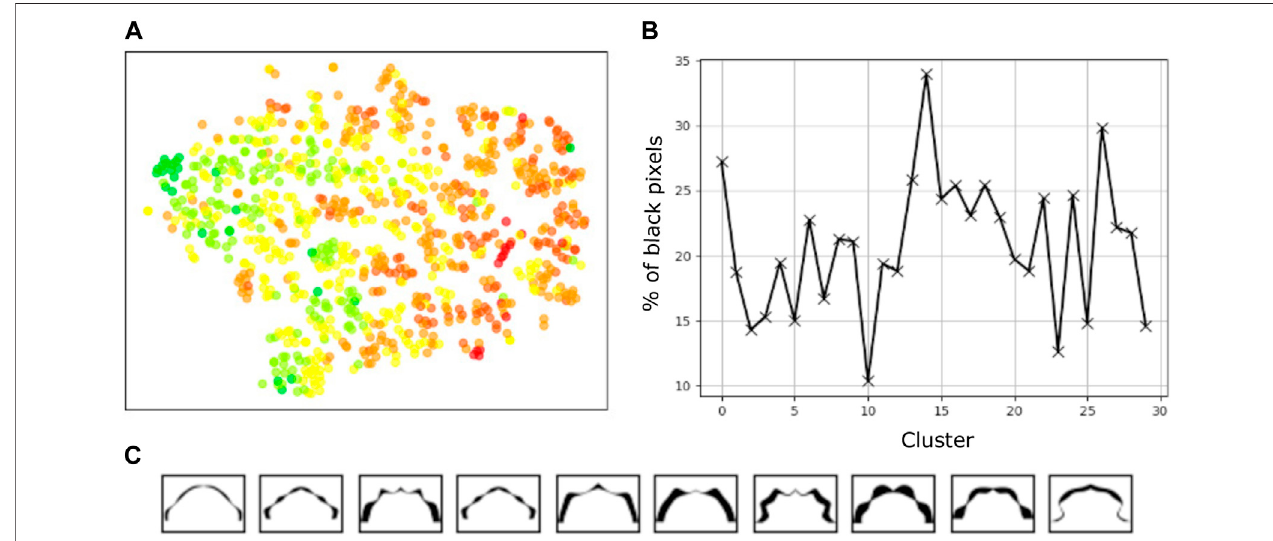
FIGURE 4 | Latent space representation of the data points coloured depending on the occupancy of the arches (a measure of the material usage) for the seismic design scenario. The latent space (A) is presented together with the plot of the mean occupancy of each cluster (B) and sample shapes from the best selected cluster (C) . Adapted from Palmeri et al. (2021) based on the CAE model of Maqdah et al. (2021).